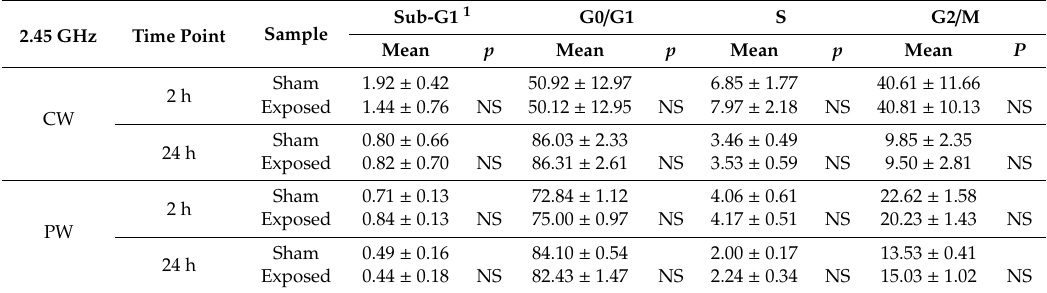
Table 1. Cell cycle analysis on HDF cells exposed to 2.45 GHz CW and PW. No di ff erences were observed 2 and 24 h after irradiation with both continuous wave (CW) and pulsed wave (PW) signals. Results are representative of three experiments. Results obtained with the cells exposed to CW or PW signals were compared to those obtained with the corresponding sham cells (exposed 2 h vs. sham 2